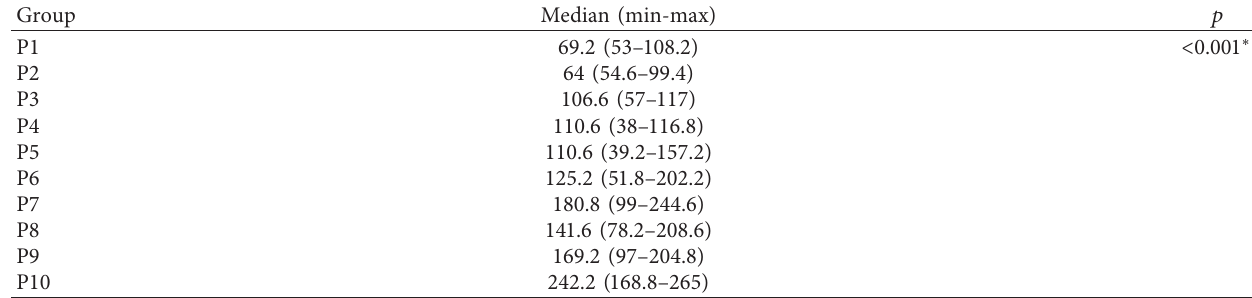
Table 3: Differences in fibroblasts assessed using the Kruskal–Wallis test.